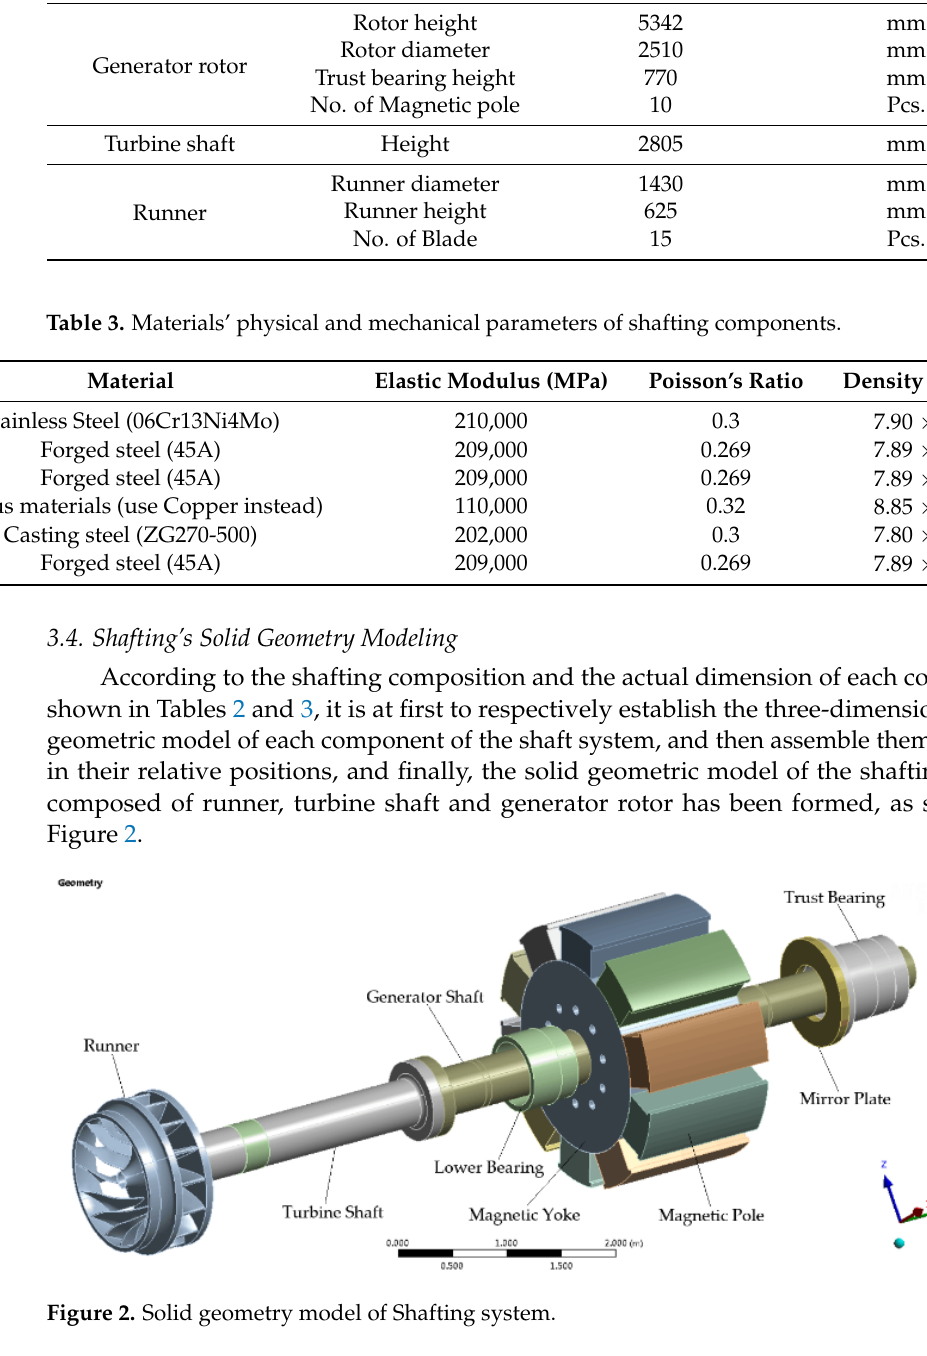
Table 2. Shafting composition and main geometric parameters of the HGU. Shafting System Dimension